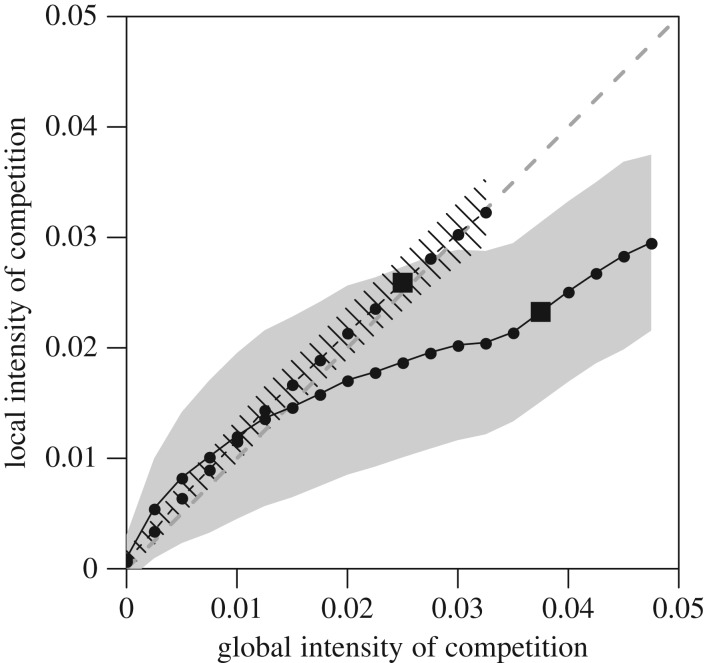
Mean ± s.d. local intensity of competition as a function of the global intensity of competition (aka population density), for populations of memoryless (dashed line and zebra area) and with-memory (plain line and grey area) individuals. The dark grey dashed line represents the isometric relationship for comparative purposes. The s.d. shown is the mean s.d. between individuals within simulations. The squares represent the global intensity of competition at the carrying capacity for both types of populations.